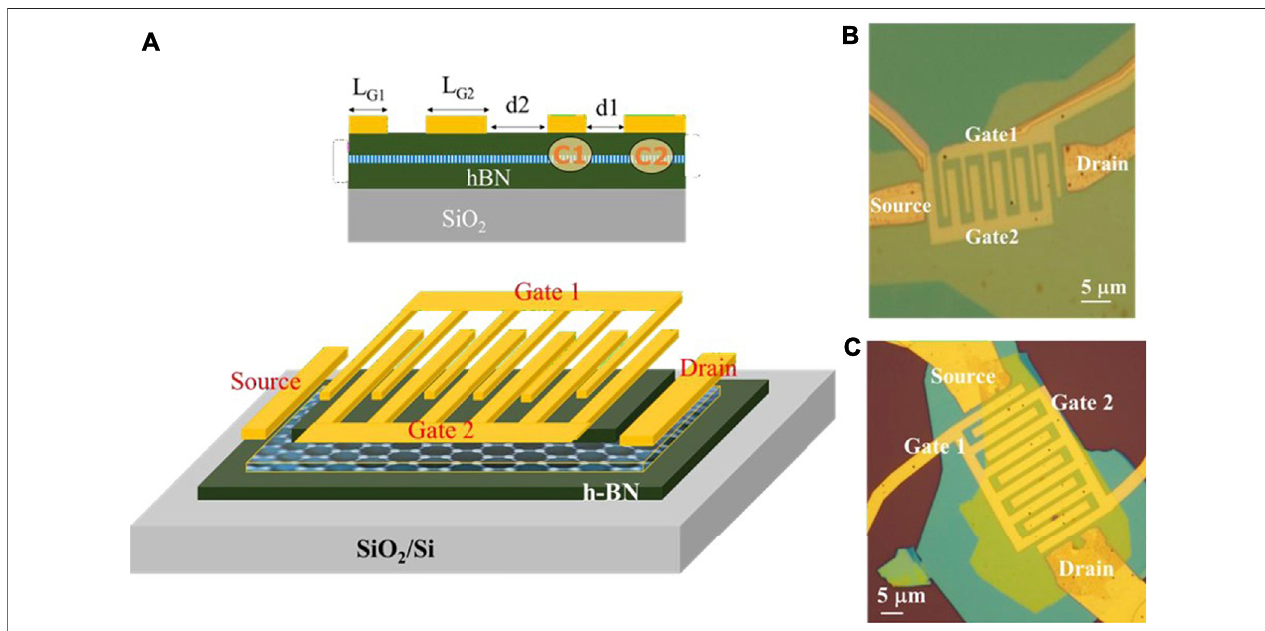
FIGURE 1 | Schematic view and device images of the DGG-GFETs. Schematic illustrating of the hBN/graphene/hBN heterostructure, including the asymmetric dual-grating-gate metallization (A) . Optical image of the asymmetric dual-grating-gate A-DGG1 (B) and the symmetric S-DGG (C) samples. After Ref. 46.